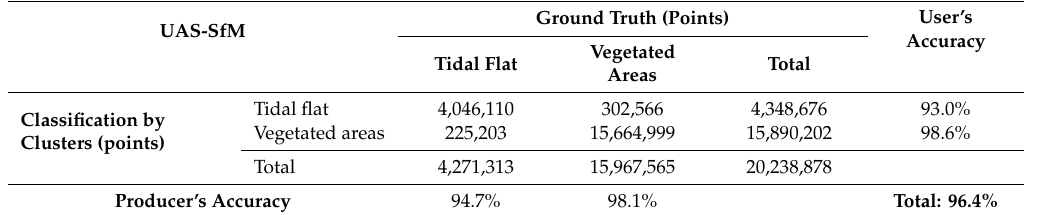
Table 5. Summary of the quantitative assessments for UAS-SfM segmentation results for 7 clusters in identifying tidal flats and areas covered by